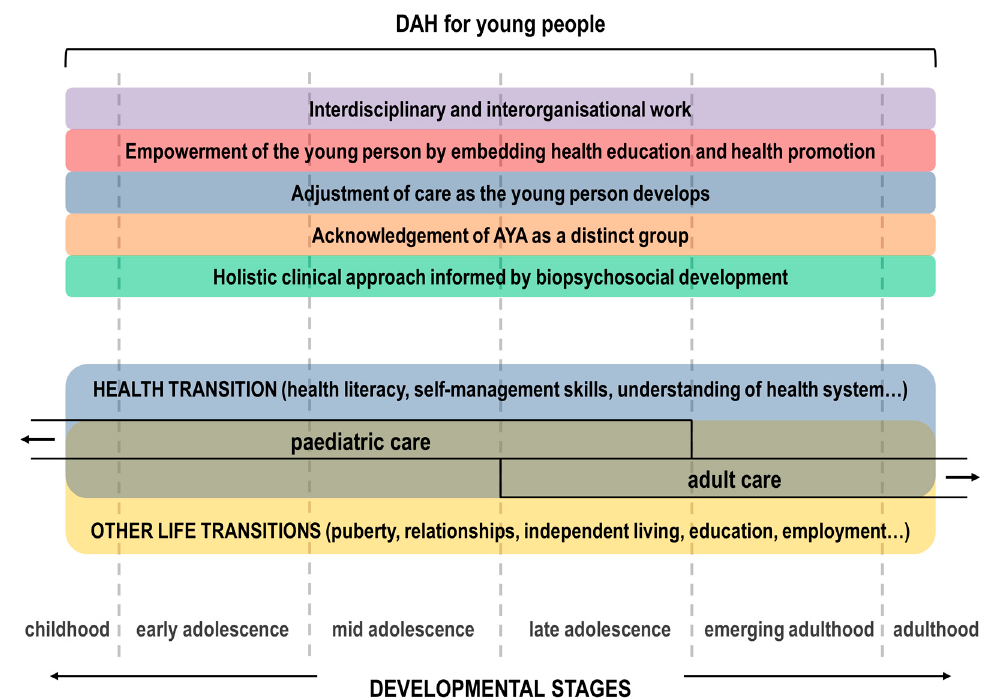
Figure 1. Schematic representation of the relationship of the five conceptual dimensions of DAH for young people to health transition and adolescent development.